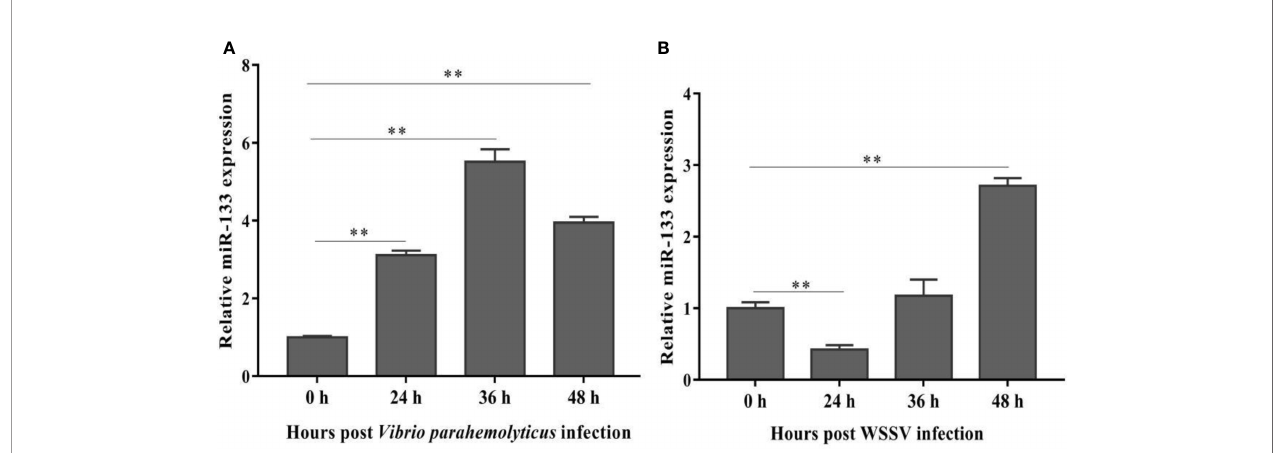
FIGURE 1 | S. paramamosain miR-133 expression following V. parahaemolyticus (A) (24 h P = 0.0000080, 36 h P = 0.000019, 48 h P = 0.0000053) or WSSV infection (B) (24 h P = 0.00064, 36 h P = 0.29, 48 h P = 0.0048) as measured using RT-qPCR. Hemocytes were collected at different times (0, 24, 36, 48 h) post challenge, and the miRNA of healthy, WSSV-infected or V. parahaemolyticus -infected mud crabs was extracted from hemocytes. Mud crab GAPDH was used as the control. Data presented were the mean ± standard deviation of three independent experiments. Signi fi cant difference between different samples is indicated by ** P <